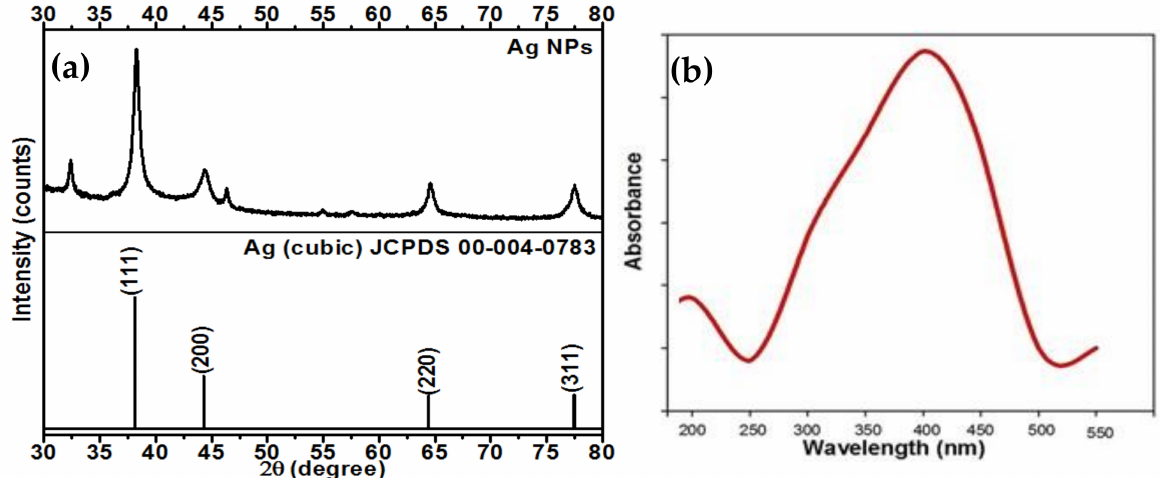
Figure 1. ( a ) XRD pattern and ( b ) UV-vis absorption spectrum of the biosynthesized AgNPs using aqueous extract of strawberry waste.